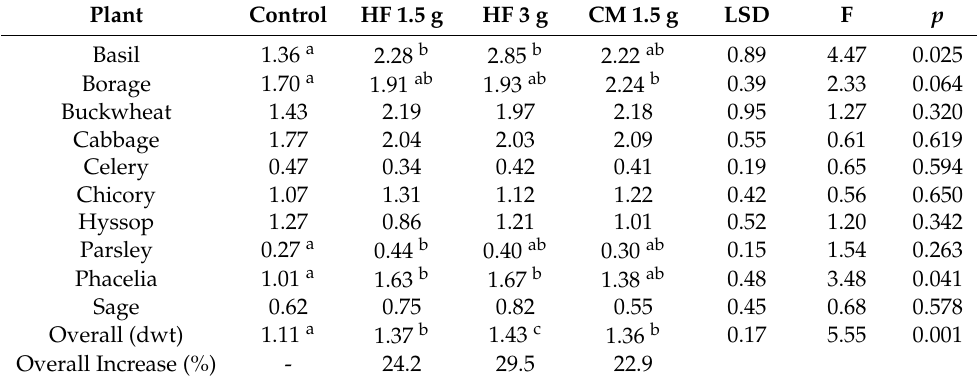
Table 1. The effect of applying Hexafrass™ (HF; 1.5 g or 3 g) and chicken manure (CM; 1.5 g) on the shoot dry weight (g) of potted plants grown in a mixture of garden soil and nutrient rich compost (mean; N = 5). LSD, F and P values for each plant obtained from one-way ANOVA. Overall values calculated using all replicates and incorporating plant species in REML analysis as a random factor. Where letter codes are given, these indicate treatments separated as by the LSD as being significantly different ( p <